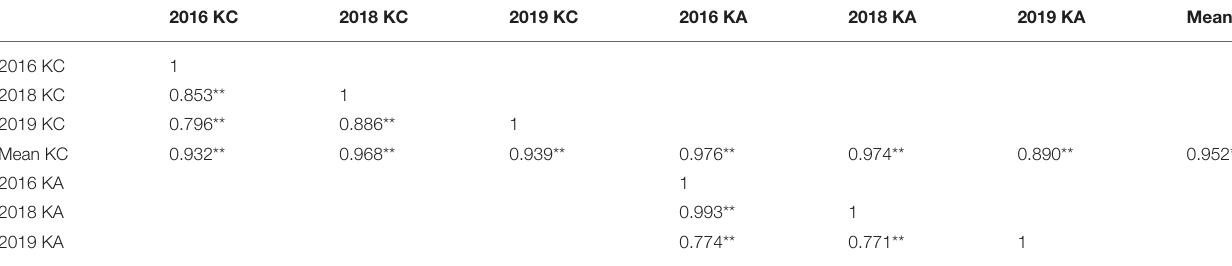
TABLE 2 | Correlation coefficients of kernels-related traits in different environments.